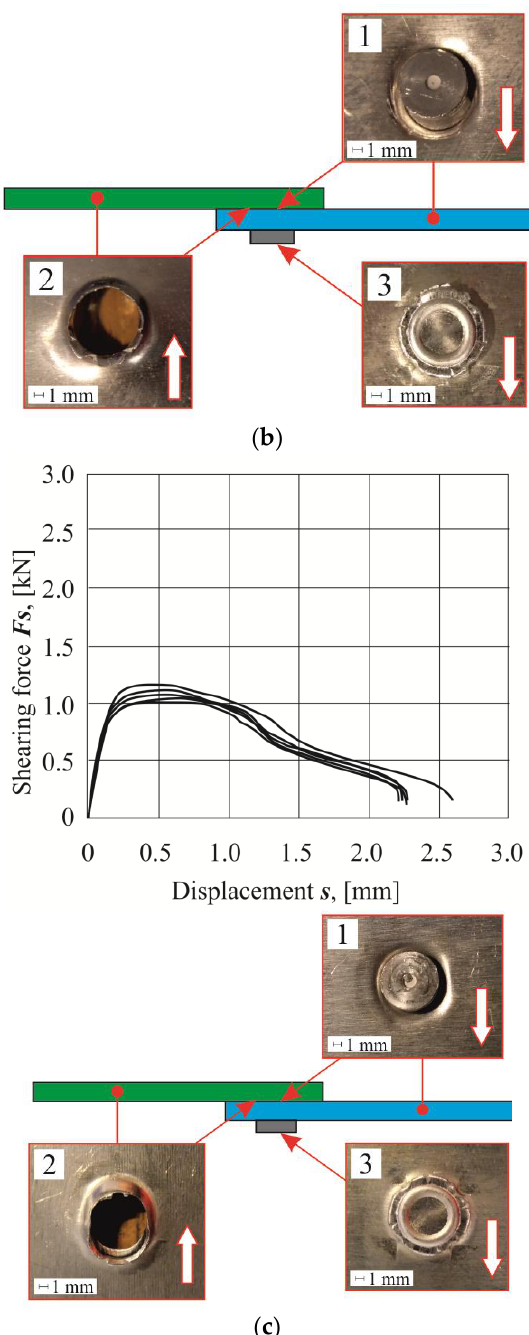
Figure 15. The tensile shear force-displacement diagrams (left side) and joint fragments after tensile shear test: ( a ) arrangement no.2 (AW 5754-H11 with AW 6082), ( b ) arrangement no.5 (AW 5754-H22 with AW 6082), ( c ) arrangement no.8 (AW 5754-H24 with AW 6082).